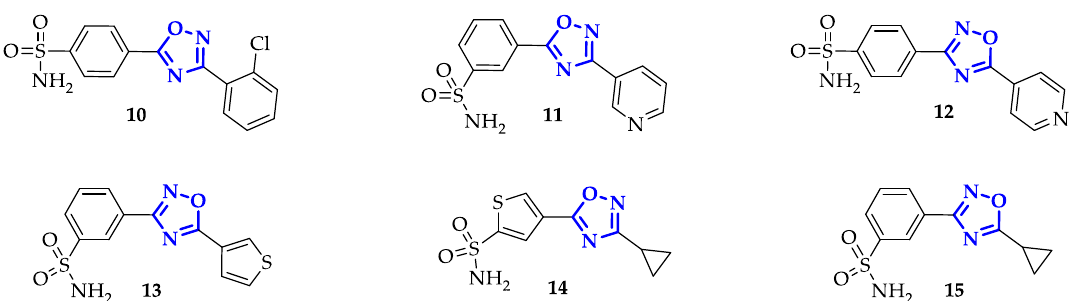
Figure 4. 1,2,4-oxadiazoles derivatives that showed a good inhibition of carbonic anhydrase IX and XII